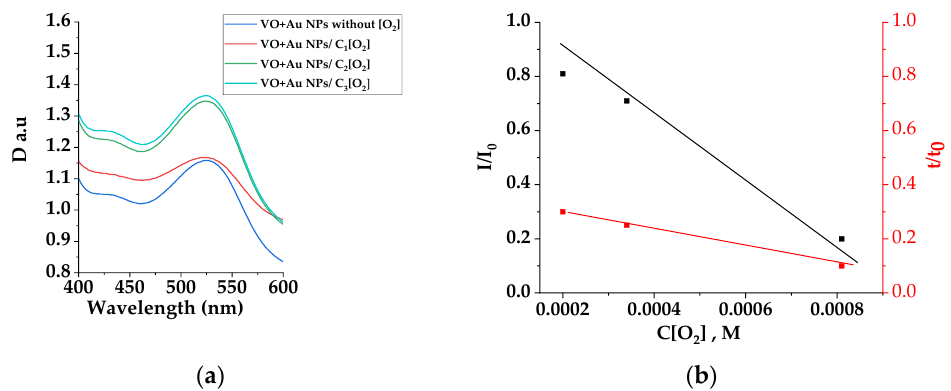
Figure 3. Absorption spectra of microemulsion with Au NPs with oxygen C 3 [O 2 ] — black curve, VO microemulsion with Au nanoparticles (C = 10 −1 0 M) without and with oxygen of different concentrations (C 1 = 2 × 10 −4 M, C 2 = 3.5 × 10 −4 M, C 3 = 8.5 × 10 −4 M) ( a ). The dependences of changes in luminescence intensity and luminescence lifetimes on oxygen concentrations at λ = 480 nm under photoexcitation with λ = 400 nm ( b ).